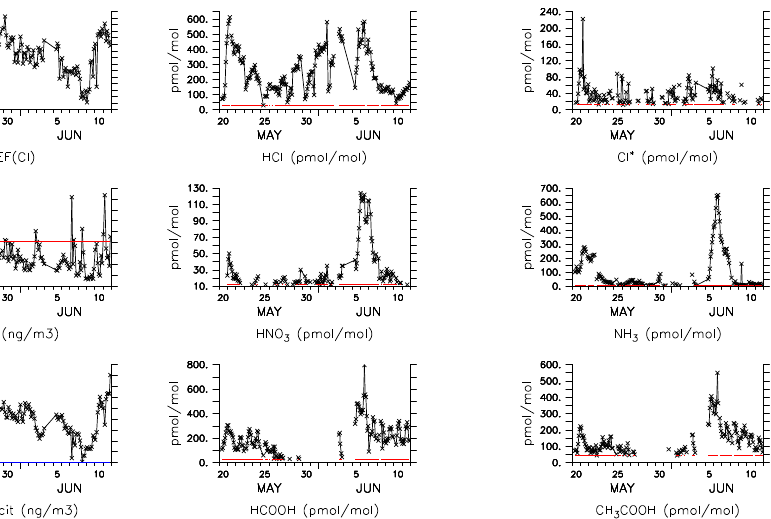
Figure 8. Time series of the mist chamber data. Cl ∗ denotes reactive chlorine. The red lines denote the detection limit.